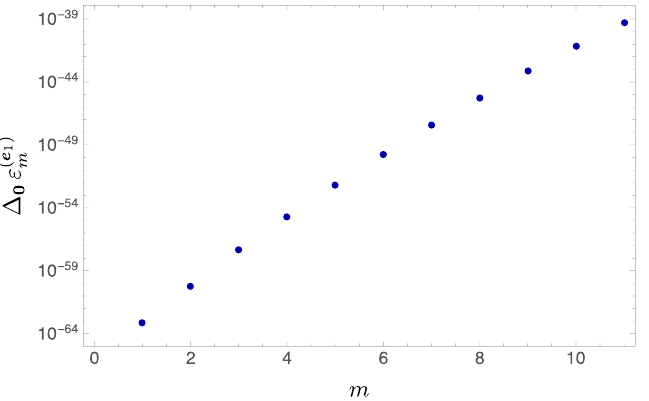
Figure 3. Di ff erences of the values of series coe ffi cients as computed from holography and predicted by large order relations, defined in Eq. (11)